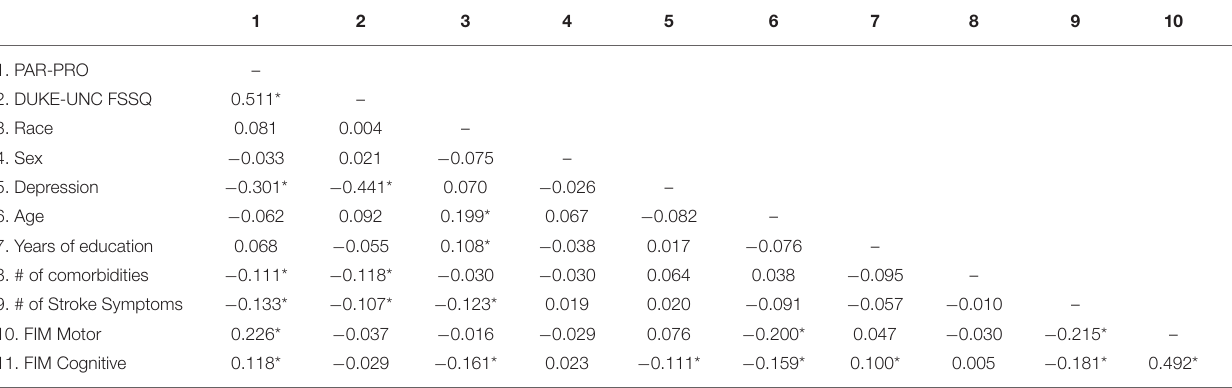
TABLE 2 | Correlation matrix of all variables.